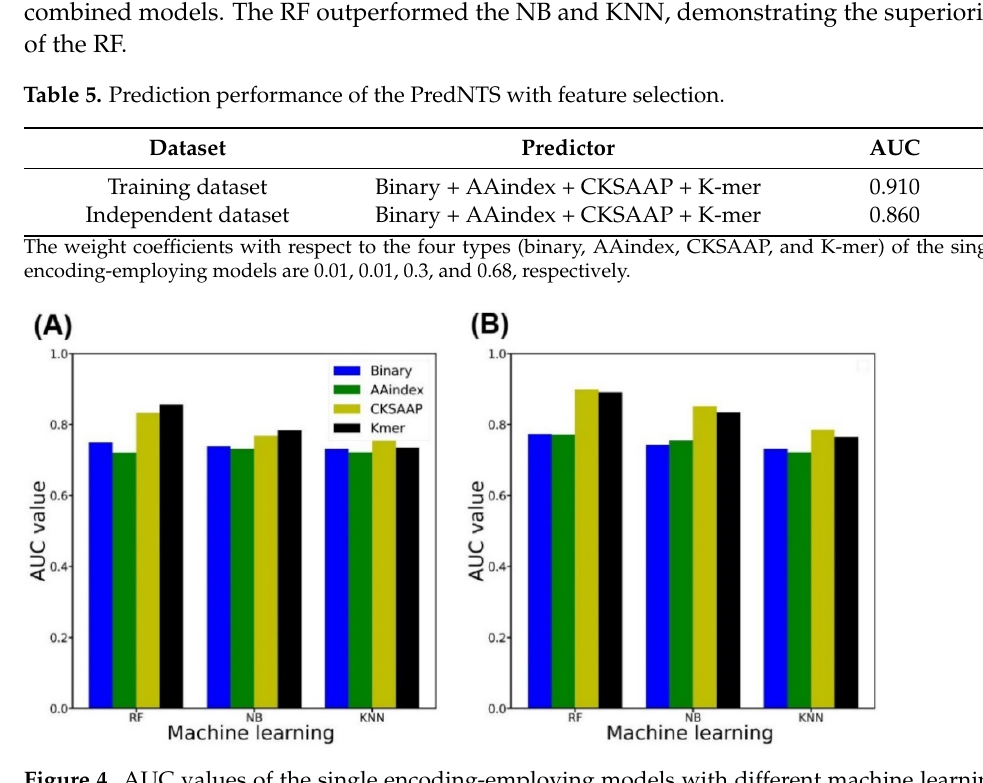
Figure 4. AUC values of the single encoding-employing models with different machine learning algorithms on training datasets. ( A ) Performance comparison of the models without any feature selection. ( B ) Performance comparison of the models with feature selection. NB, naïve Bayes; KNN, k-nearest neighbor; RF, random forest.